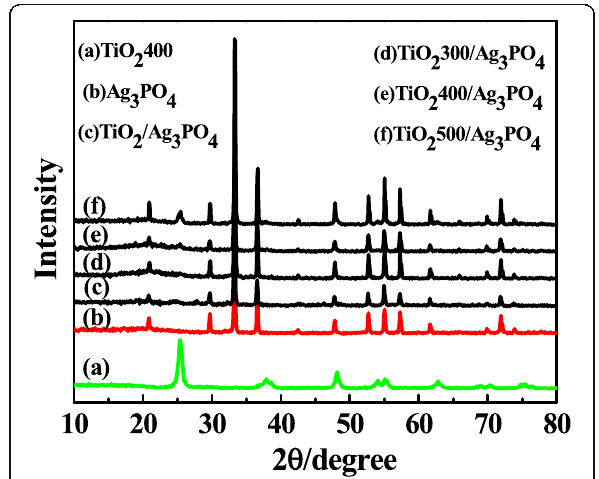
Fig. 1 The XRD patterns of the as-prepared